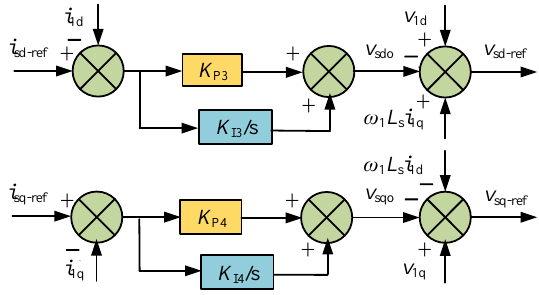
Figure 5. Inner current controller loop of the STATCOM. (a) DC voltage controller. (b) AC voltage/ reactive power.